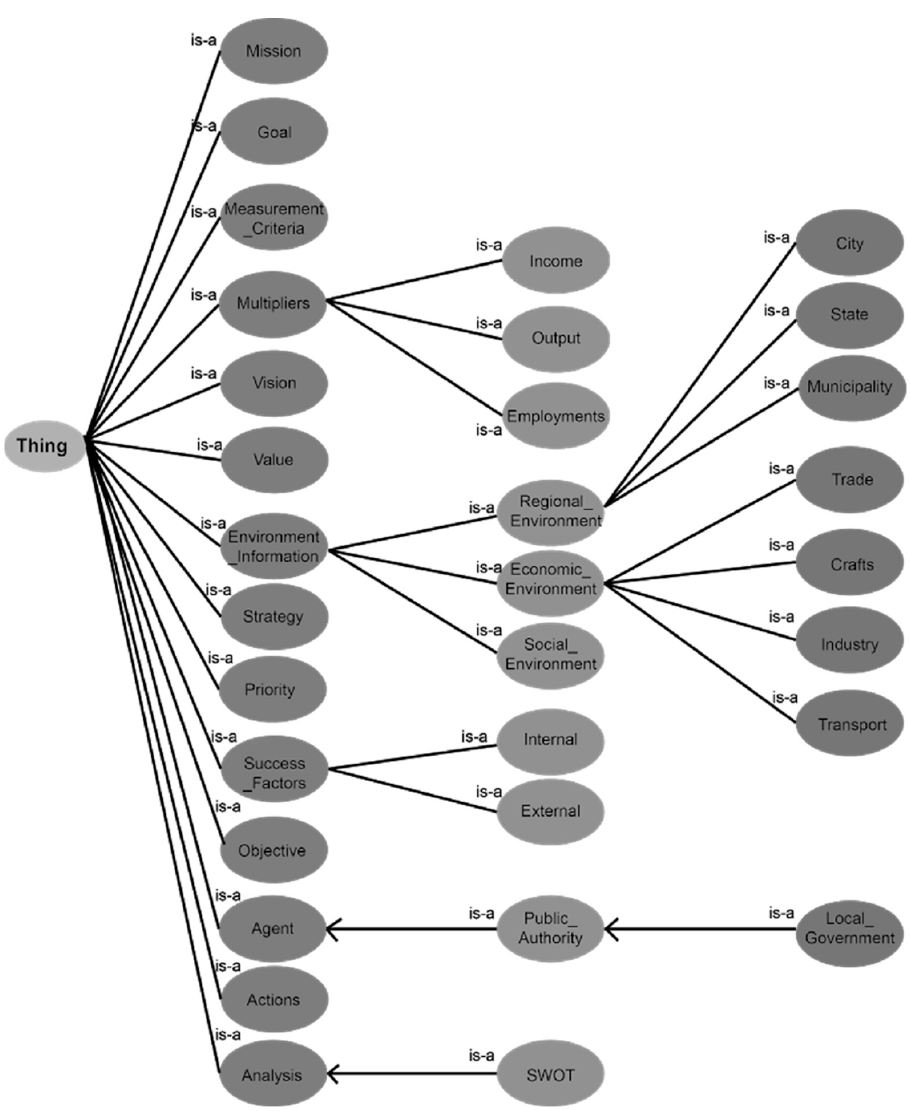
Figure 1. SPO ontology.